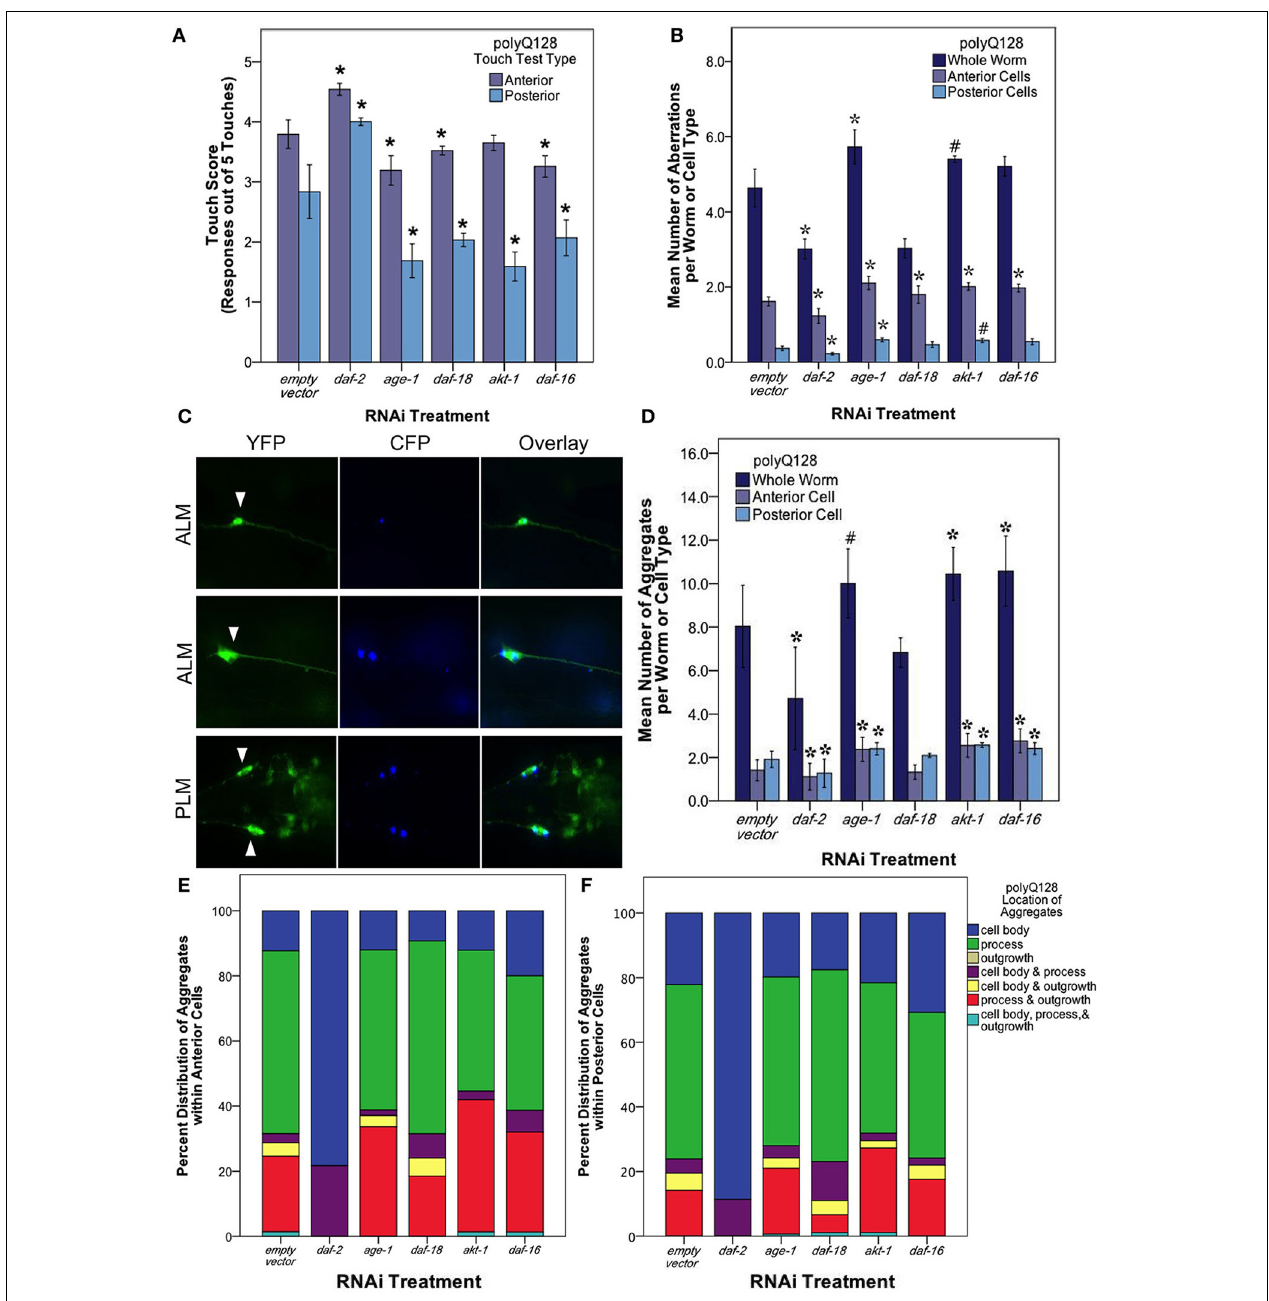
FIGURE 5 | The insulin signaling pathway mediates mechanosensory neuron morphology and function in polyQ128 animals. (A) Anterior and posterior touch test scores, representing the number of positive responses to 5 soft touches, following RNAi treatment for indicated insulin signaling pathway gene of polyQ128 animals. (B) Mean number of neuronal aberrations per whole animal (sum of all 4 neurons scored in an individual) and individual cell type (anterior [ALML or ALMR] and posterior [PLML or PLMR]). (C) Representative image of polyQ128 aggregate (CFP, blue panels) accumulation within anterior (ALM) and posterior neurons (PLM) (YFP, green panels). White arrows in YFP panels indicate the location of